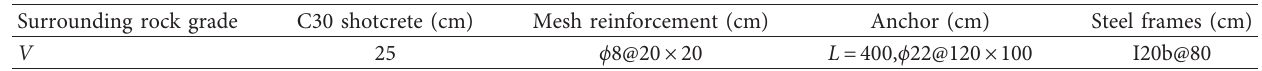
Figure 3: Failure form of initial support. (a) Severe beyond-limit deformation of initial support. (b) Distortion of structural steel frames. Table 3: Initial support parameters table.